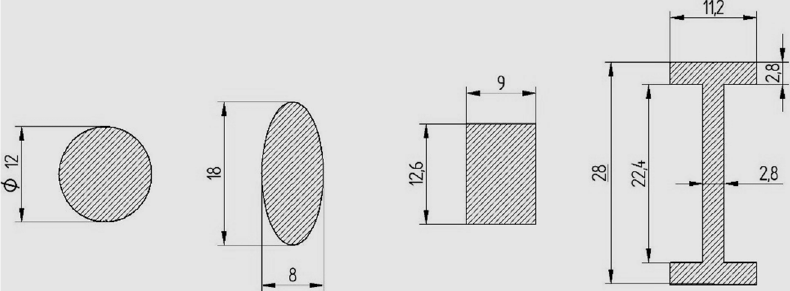
Figure 1. Shapes and dimensions of the bar-type specimens (ISO metric drawing standard).